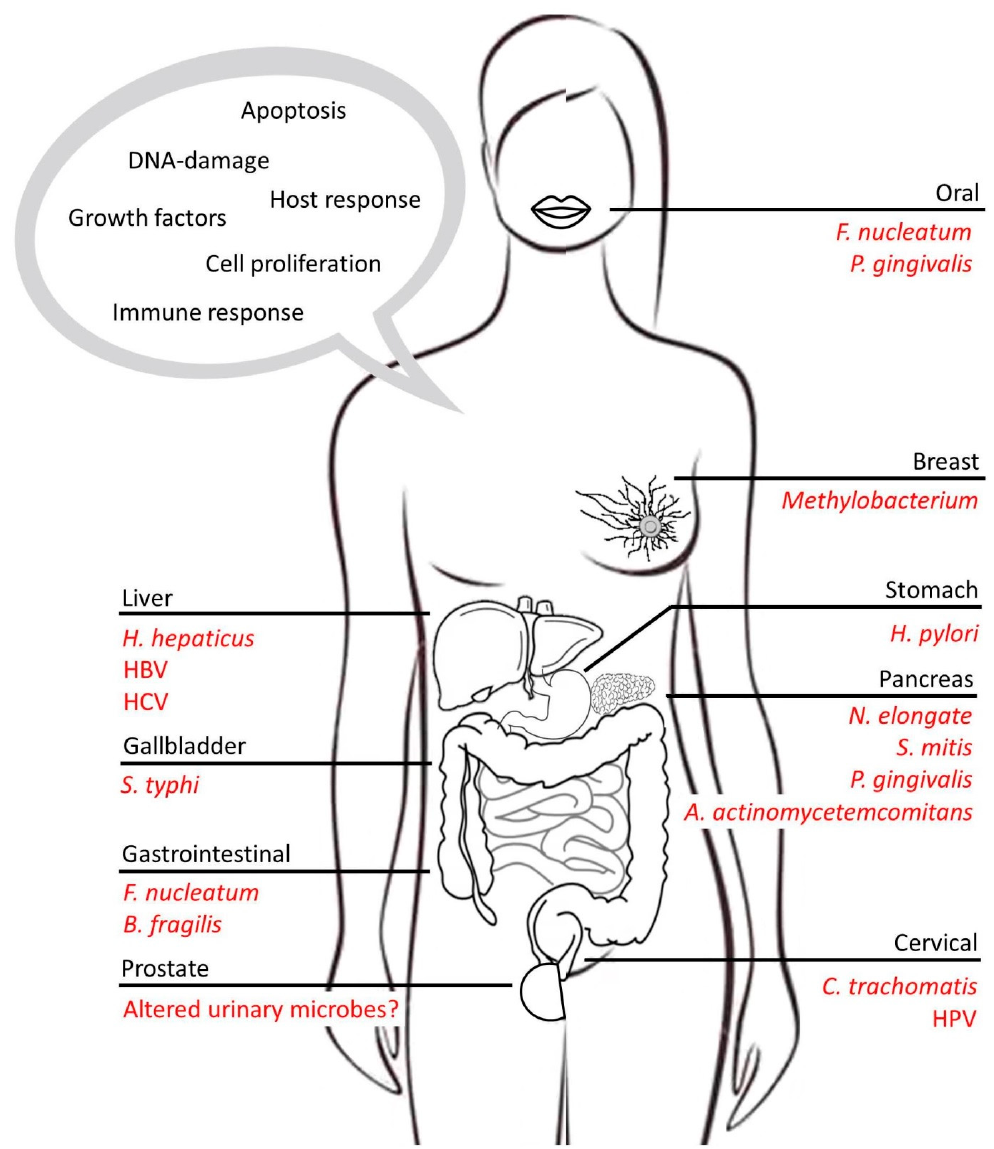
Figure 1. Highlighting the role of microbes in cancer and the key pathways mediated by microbes within host cells.